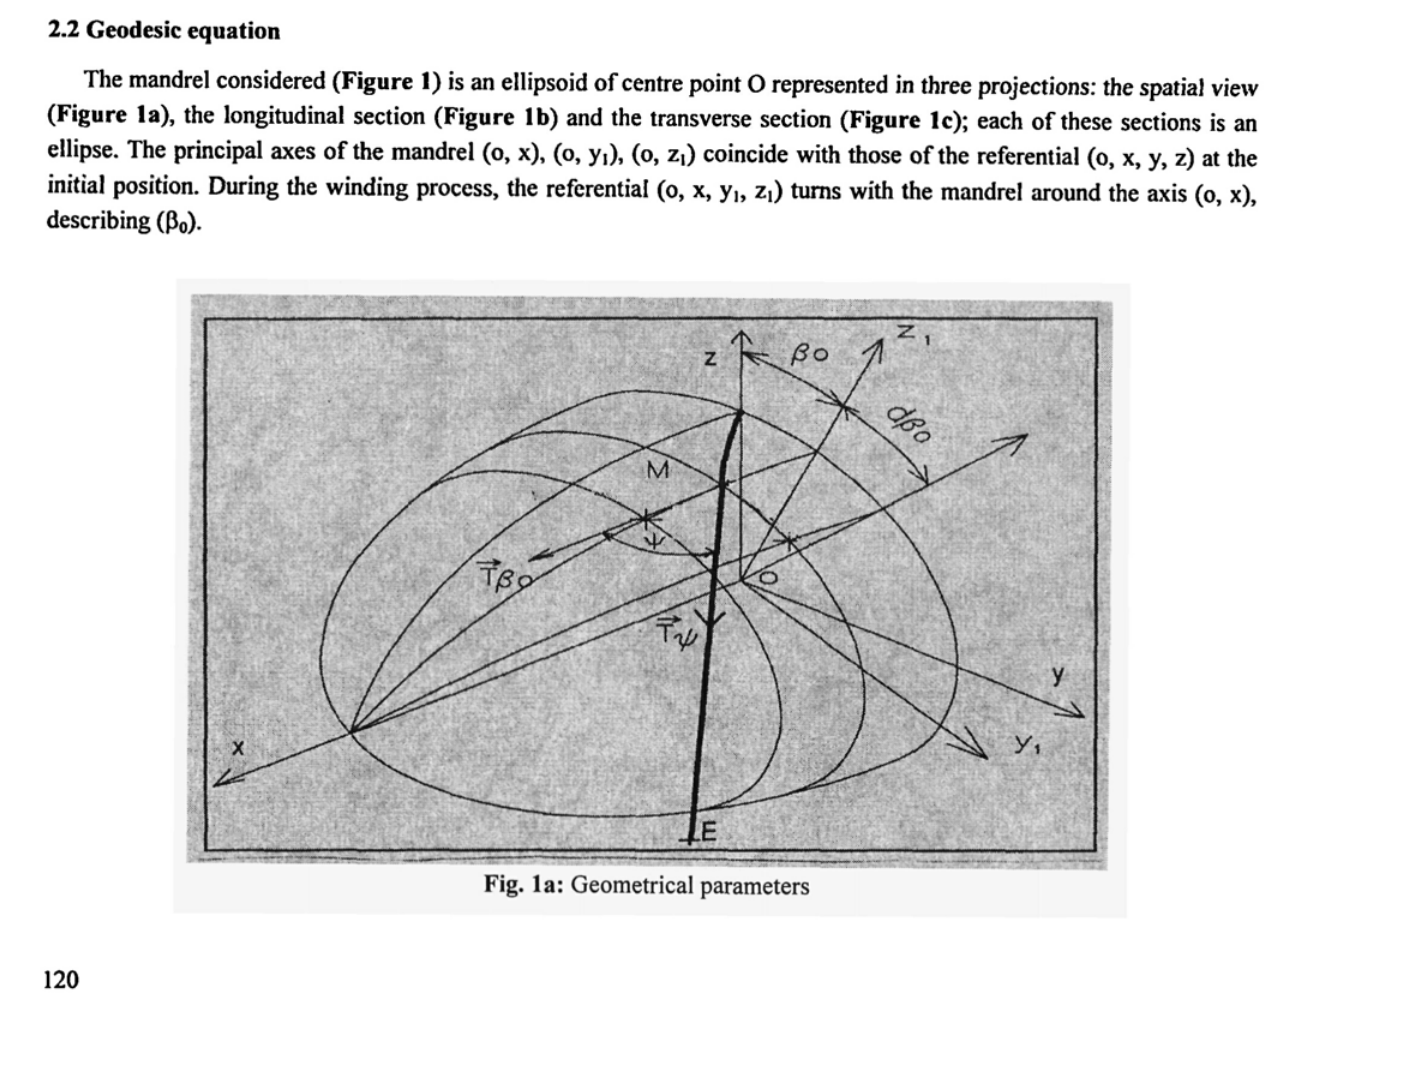
Fig. la: Geometrical